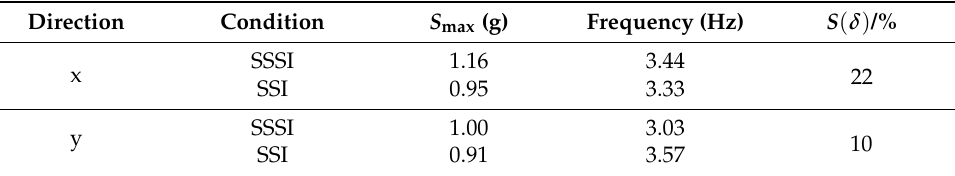
Table 14. Comparison of FRS in X and Y directions of key floor reference points of SSI system and SSSI